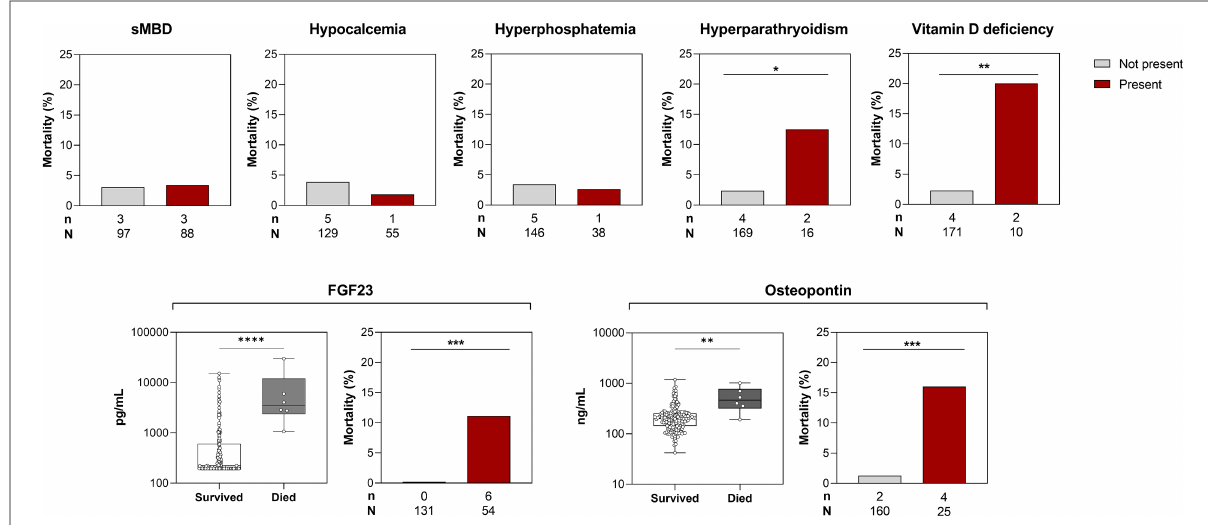
FIGURE 5 Relationship between sMBD and mortality in children with SCA. Top. Bar graphs depicting the frequency of children who died in-hospital based on the presence of sMBD or individual mineral abnormalities. Bottom. Box plots depicting serum levels of FGF23 and osteopontin at enrollment in children based on in-hospital mortality with differences between groups assessed using the Wilcoxon rank sum test. The corresponding bar graphs depict the frequency of in-hospital death among children with elevated levels of FGF23 and osteopontin using the 95th percentiles from Ugandan children with SCA in steady state to de fi ne the reference range. Differences in dichotomous variables and mortality assessed using Fisher ’ s exact test. * p <0.05, ** p <0.01, *** p <0.001, and **** p